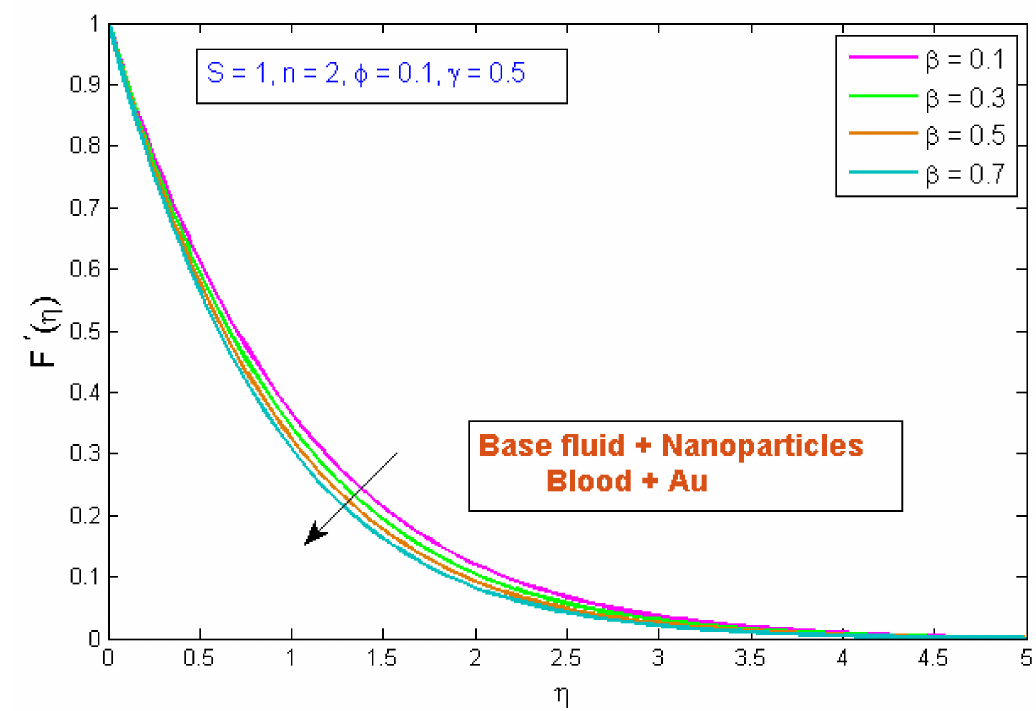
Figure 6. Modification of F (cid:48) ( η ) versus β .